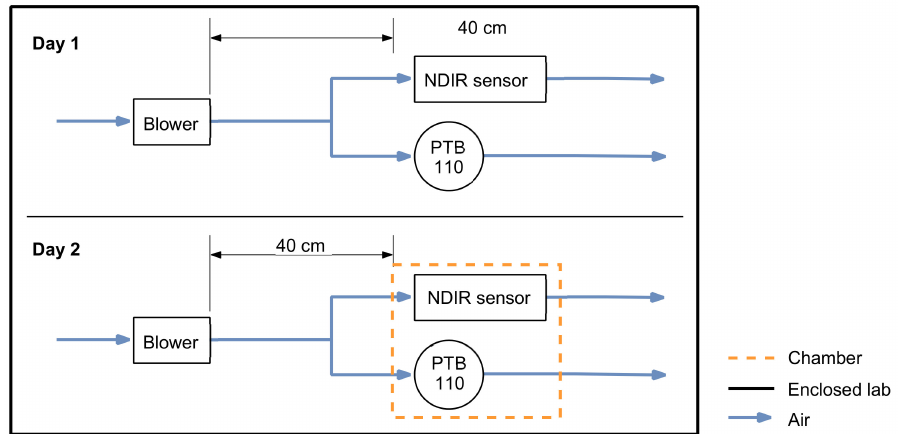
Figure 4. Chambered and chamber-less comparative measurement test setups illustrated with a simplified diagram. The blower is optimally placed and configured to acclerate airflow for producing simulated rotor downwash flow. The indoor environment is relatively enclosed, with no known source or sink of CO 2 and no source of extra airflow. We used a CARBON3060 NDIR sensor and a Vaisala PTB-110 barometer for measuring CO 2 concentration and air